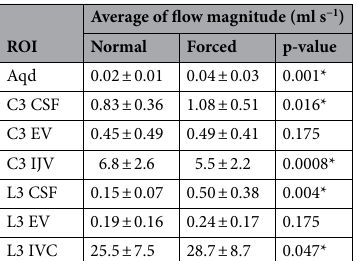
Table 1. Average of flow magnitude during normal and forced breathing, mean ± SD across subjects. Aqd = aqueduct; C3 = cervical level 3; L3 = lumbar level 3; EV = epidural veins; IJV = internal jugular vein; IVC =inferior vena cava; normal = normal breathing; forced = forced breathing; * = p < 0.05.